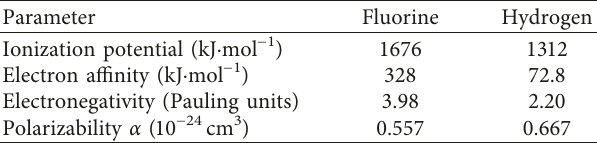
Table 1: Atomic characteristics of fluorine and